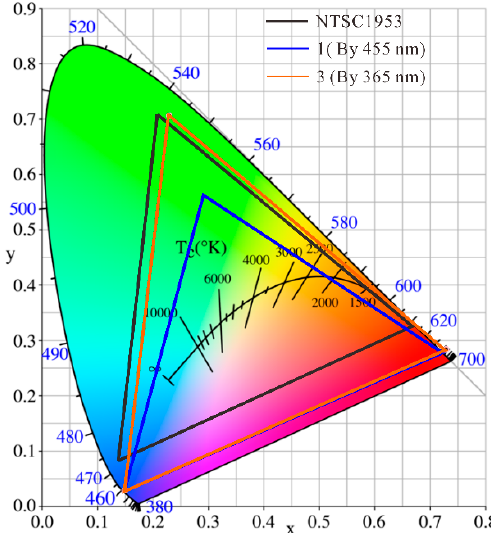
Figure 12. Comparison of color gamut between blue (455-nm) excitation and ultraviolet (365-nm) excitation solutions. Table 1. Comparison of color gamut for wavelength solutions with different excitations.